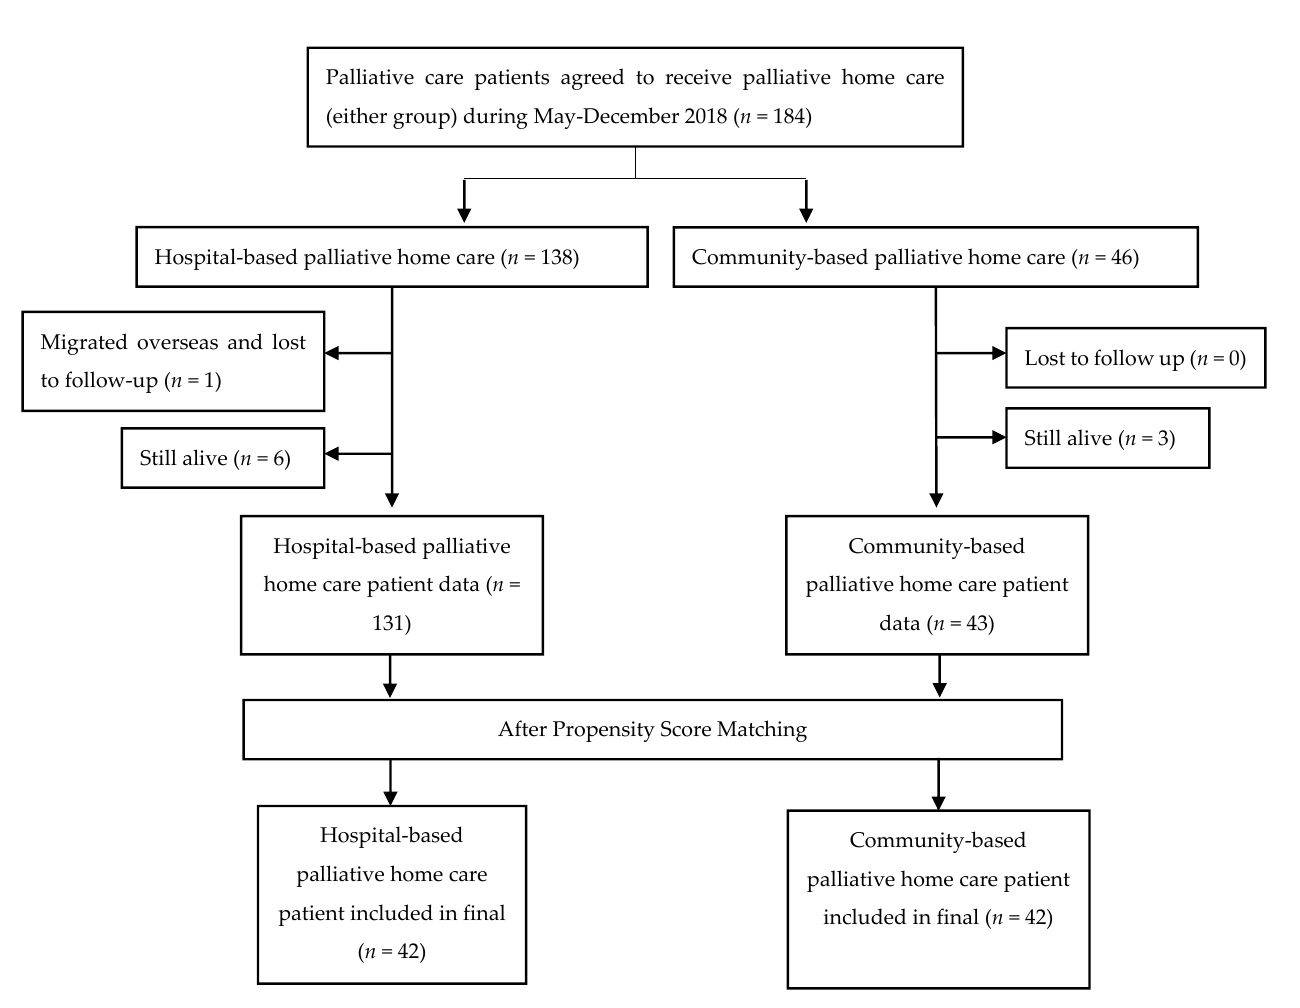
Figure 2. Patient selection flowchart. Table 1. Demographic and clinical characteristics of enrolled